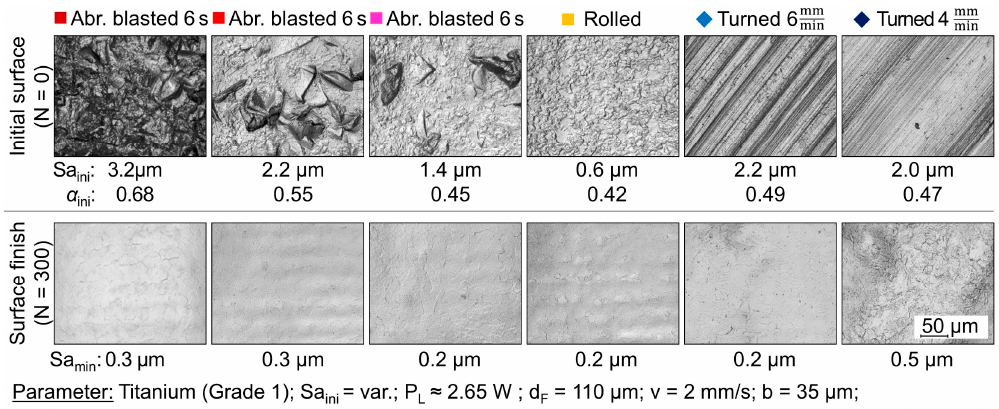
Figure 5. Microscopic images of the pre-machined and final surface finish after 300 passes.